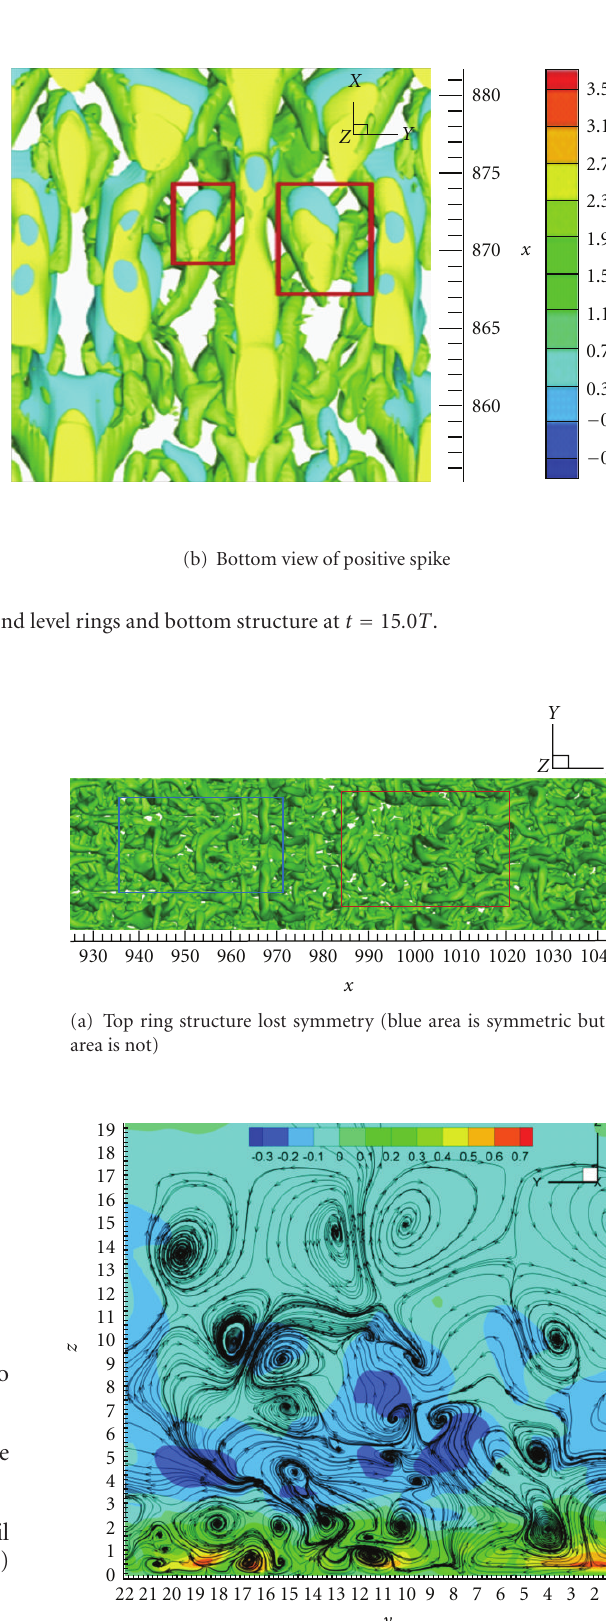
Figure 37: The whole flow field lost symmetry at t = 21 . 25 T